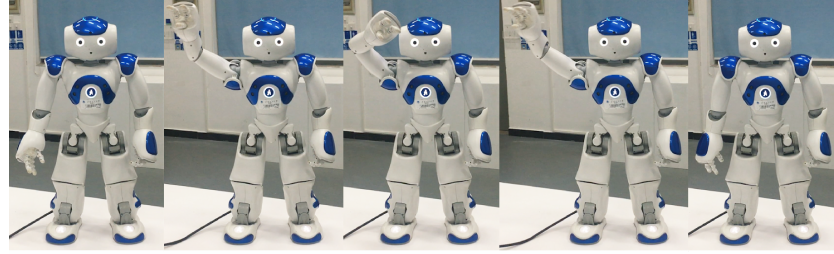
Figure 22. The snapshots of the reproduced hello motion performed by